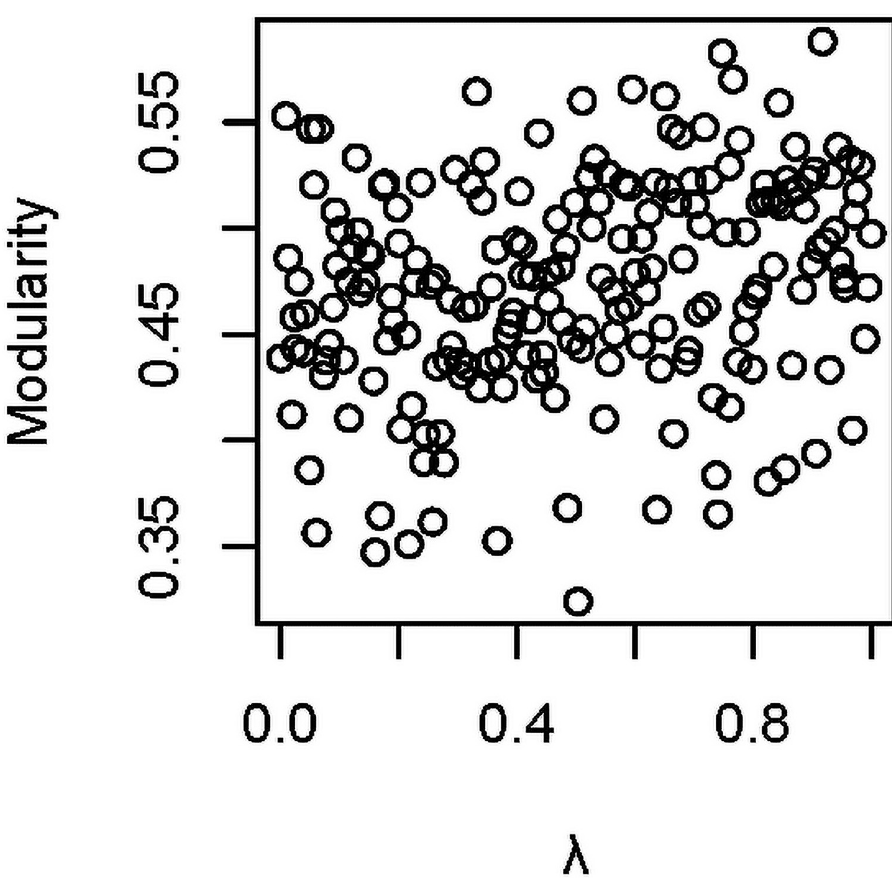
Fig 4. Association between phylogenetic signal ( λ ) and modularity ( Q 0 ). Results are from bivariate tests, with λ h1 = λ v .